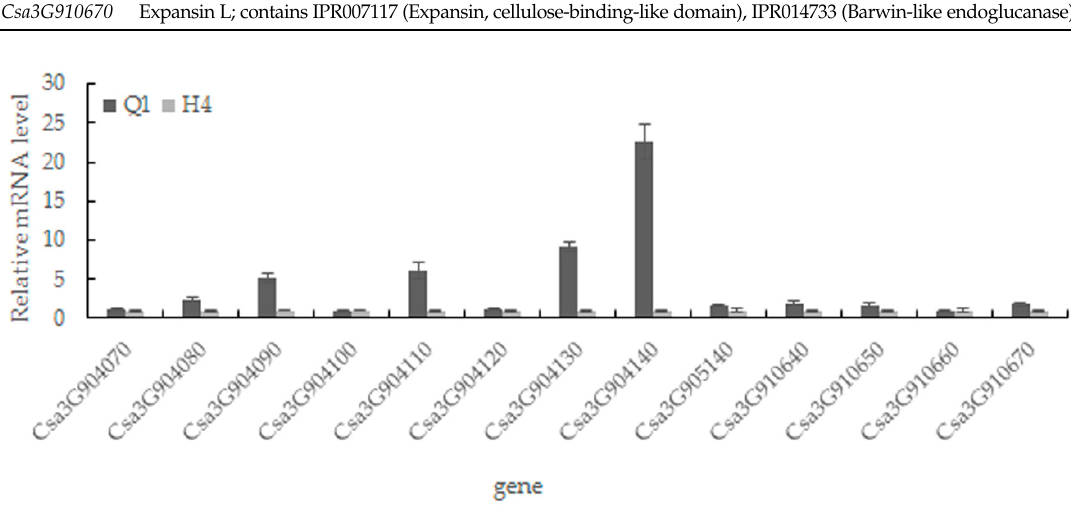
Figure 5. Quantitative real-time PCR analysis of the candidate gene in Q1 and H4. The data are presented as the average values of three replicates.